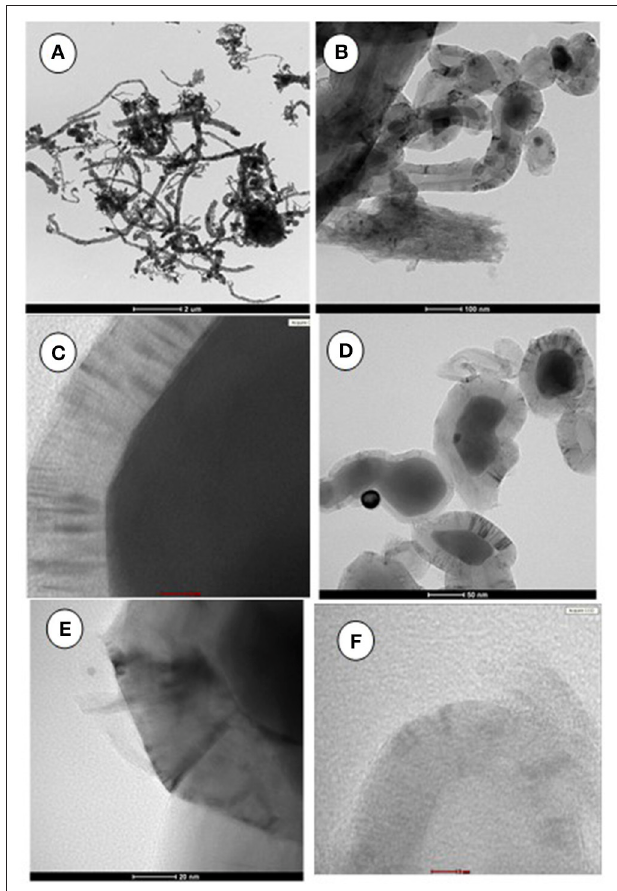
FIGURE 8 | TEM images of Ni/BC catalyst after reaction at: 850 ◦ C (A,B) : 900 ◦ C; (C,D) 950 ◦ C (E,F)